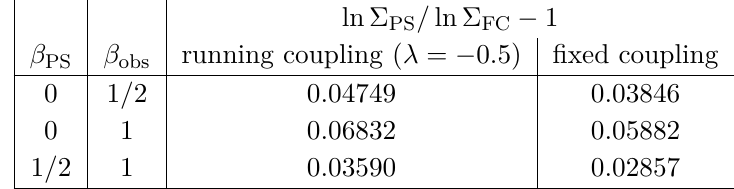
Table 2. Value of the LL discrepancy for α s → 0 with fixed λ = α s L = − 0 . 5 for various shower- observable combinations in the CFFE colour